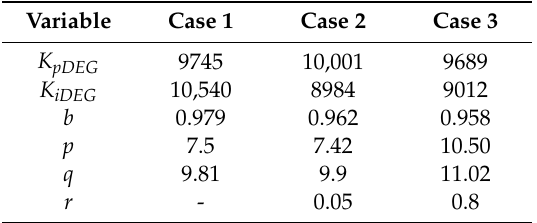
Table 7. Optimum 2DOF PI controller parameters after leveraging the FPA.